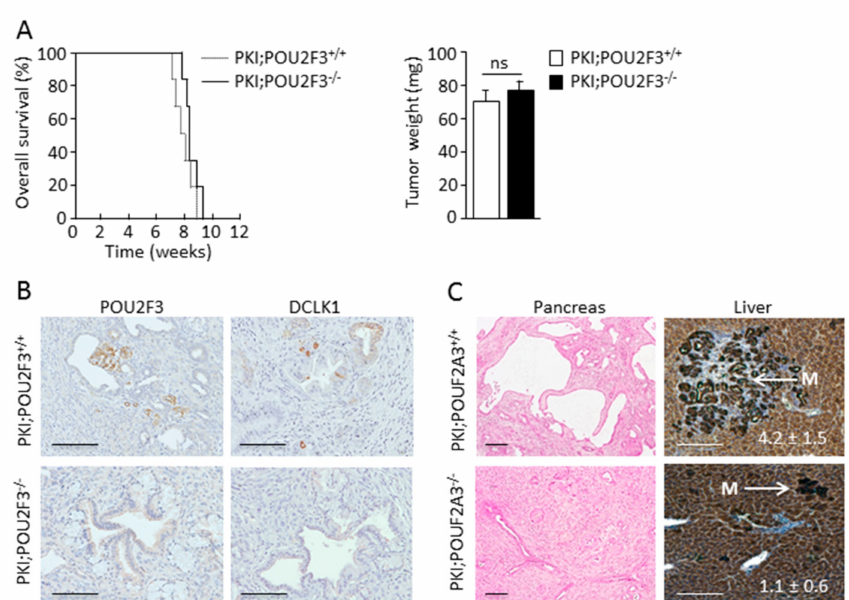
Figure 1. POU2F3 is not essential for pancreatic carcinogenesis but it is critical for liver metastasis. ( A ) Kaplan Meier survival curve of PKI;POU2F3 +/+ and PKI;POU2F3 − / − mice (left panel) and the tumor weight at the sacrifice time (right panel). ( B ) Immuno-staining of POU2F3 and DCLK1 in the pancreas from PKI;POU2F3 +/+ and PKI;POU2F3 − / − mice. ( C ) Hematoxylin and Eosin staining of the pancreas and liver from PKI;POU2F3 +/+ and PKI;POU2F3 − / − mice. Values denote the metastasis per liver. Scale set as 100 µ